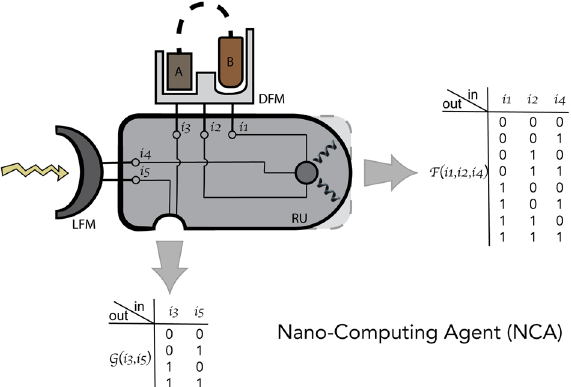
Fig. 1 A conceptual diagram of the NCAs. The response unit (RU) is controlled by light- or drug-sensitive regulatory units (LFM, DFM). The control is established either via allosteric networks within proteins or through direct steric interactions. The inputs i 1 ; ¼ ; i 5 f g and the outputs F and G are represented as binary functions for simplicity.